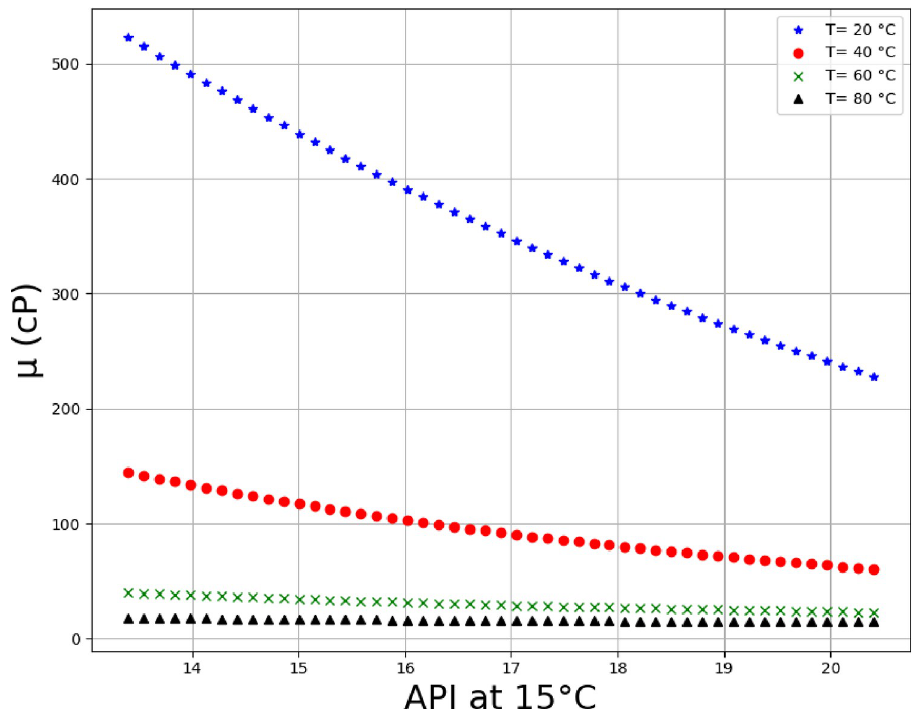
Fig 11. Trends of API on multiple temperature levels (%C4 = 0.35, %C5 = 1.62, %C6 = 3.21, %C7+ = 94.81, MWC7 + = 338.41, SGC7+ = 0.95, ρ (g/cc) at 20˚C = 0.941).